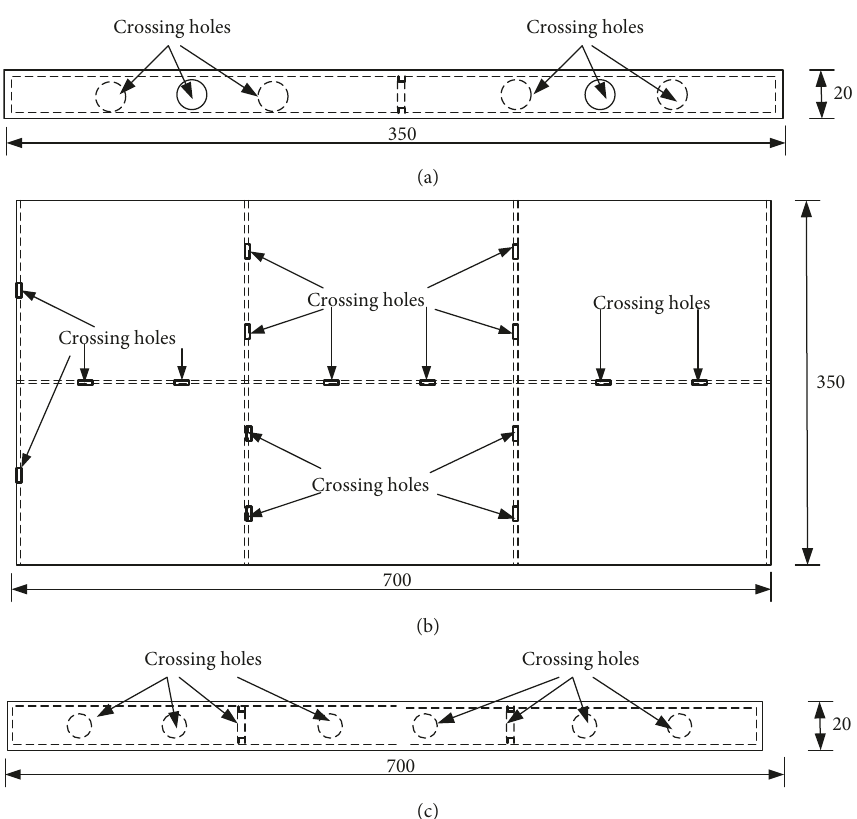
Figure 16: Shape and sizes of the test specimens. (a) Side view of specimen. (b) Top view of specimen. (c) Front view of specimen.